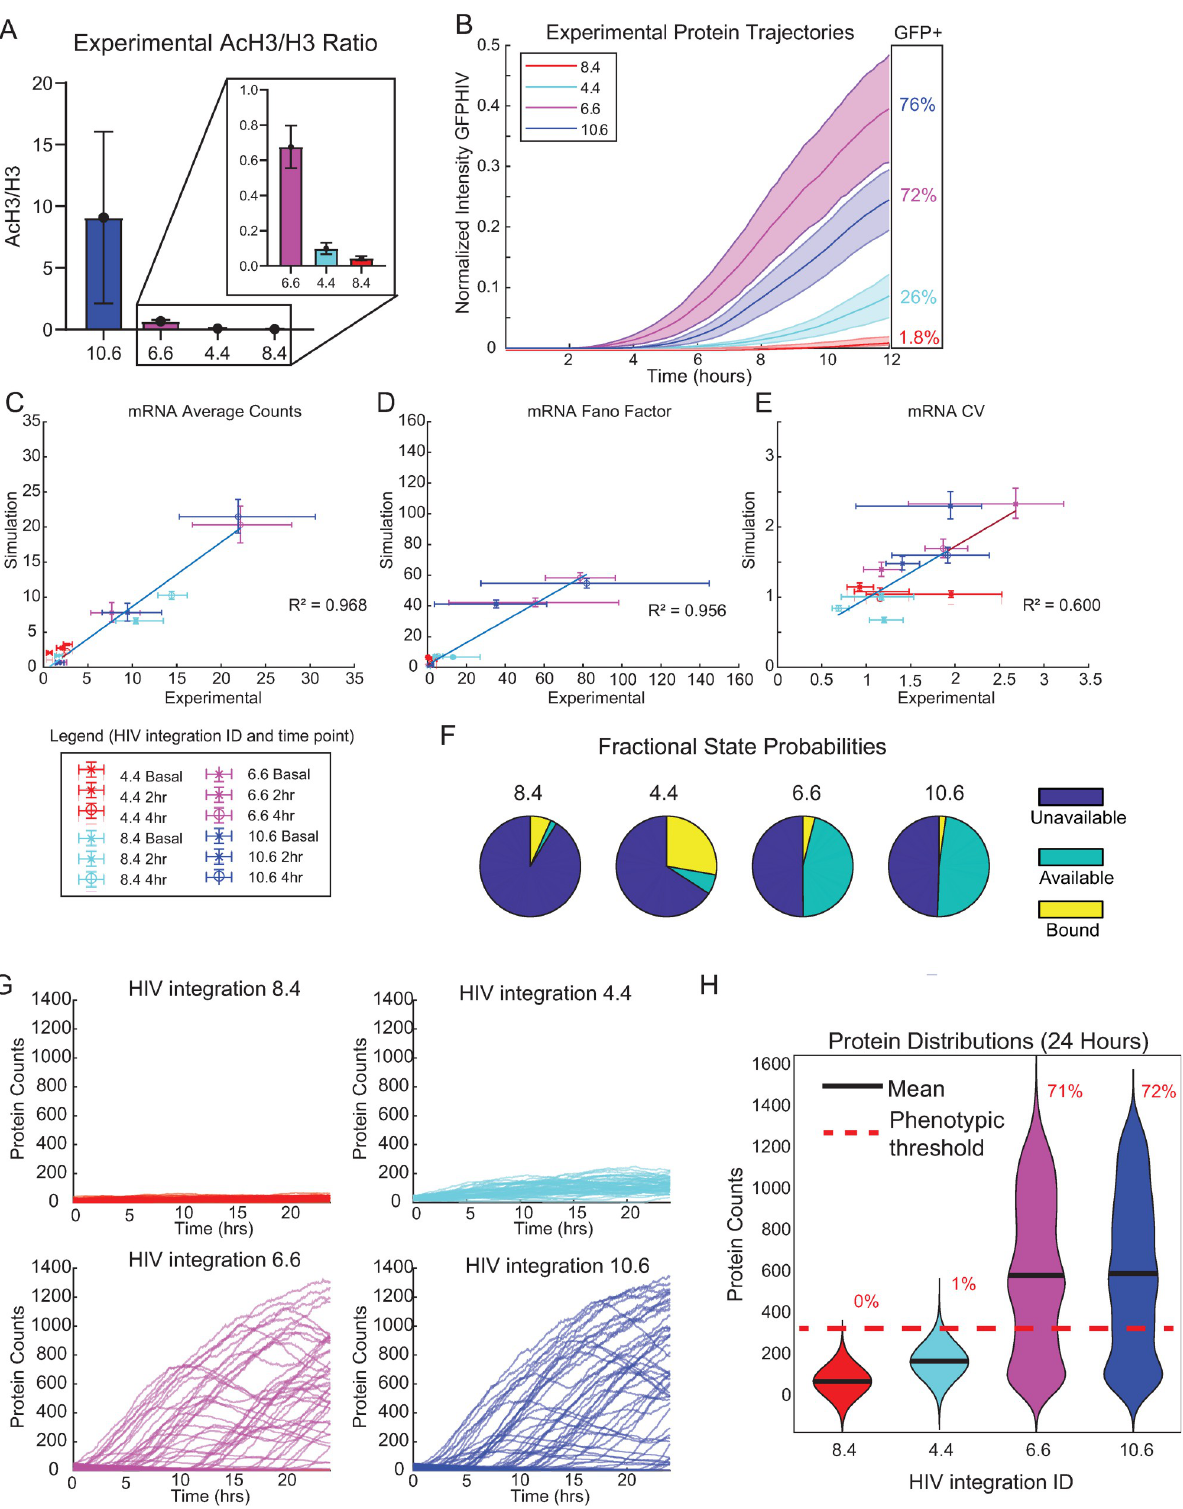
Fig 5. The three-state transcriptional cycling model reproduces transcriptional activation heterogeneity observed for a range of latent HIV integrations. (A) Ratio of enrichment of total histone H3 to acetylated H3 (AcH3) in Jurkat T cells at the indicated target promoters quantified by ChIP-qPCR. Data are presented as mean of % input (non-IP control) ± SD of two biological replicates. (B) Experimental GFP-HIV trajectories for